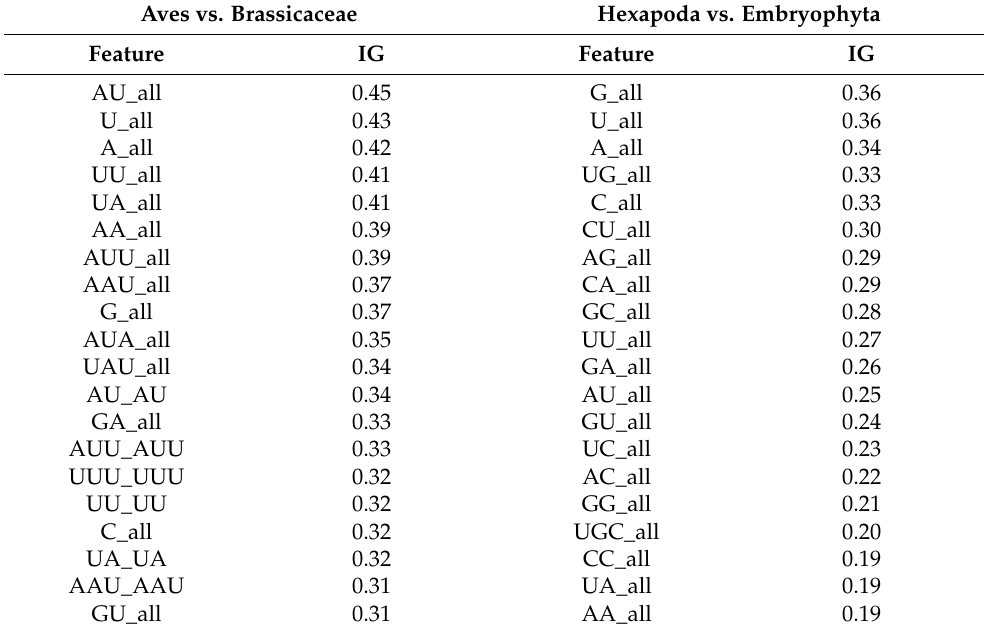
Table 2. An example of ranked features based on IG. The features ending with “_all” are related to “Inter k-mer distance”, while the rest are related to the k-mer first–last distance. Aves vs.